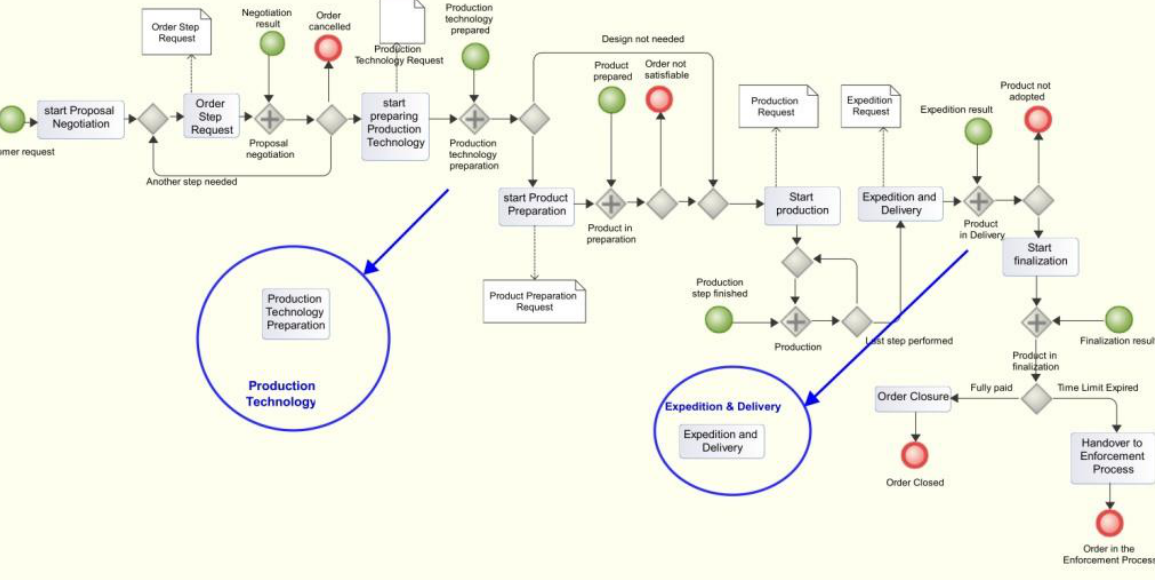
Figure 7 . Example – Process in the 4th Normal Form